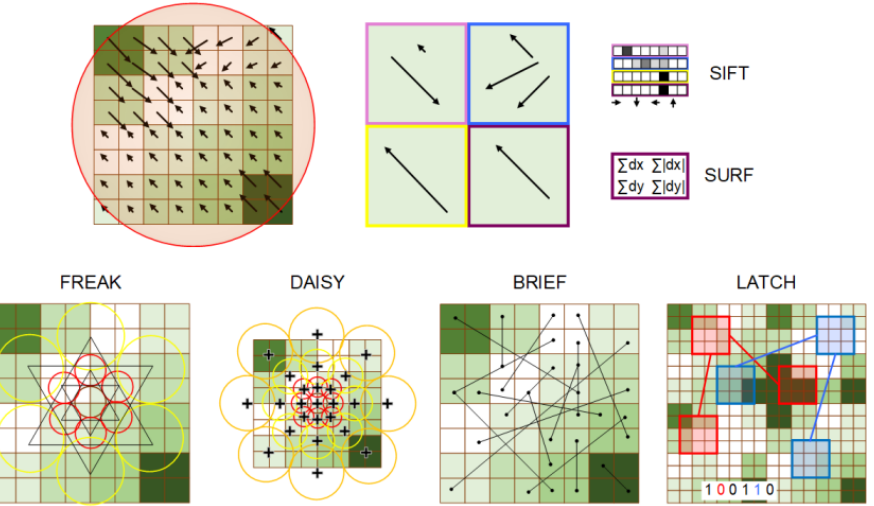
Figure 1. Visualization of the computation of feature descriptors. At the top are examples of features derived from gradients and encoded as real values. At the bottom are different approaches for building a binary string for data